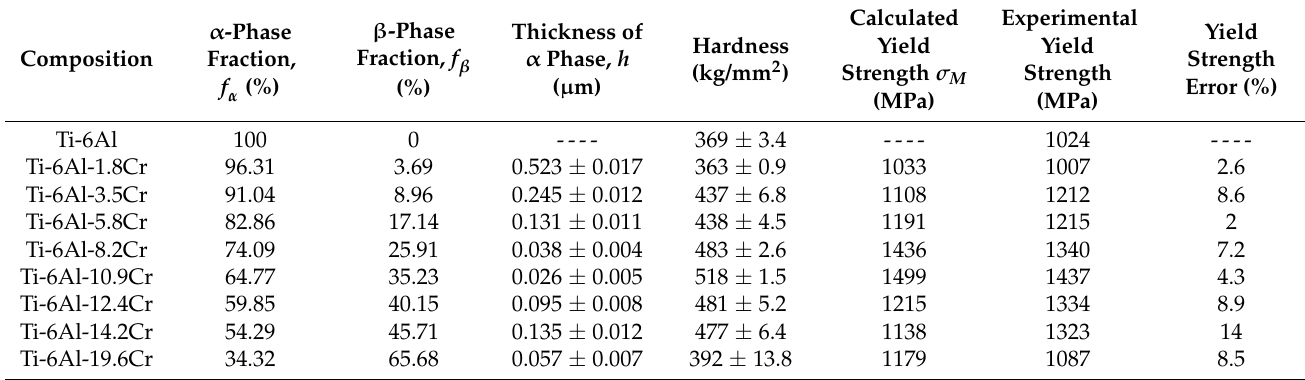
Table 1. Summary of the calculated fractions of the α and β phases ( f α and f β ) and thickness of the α phase ( h ), experimentally determined values of hardness, experimental yield strength obtained from hardness, calculated yield strength, and yield strength